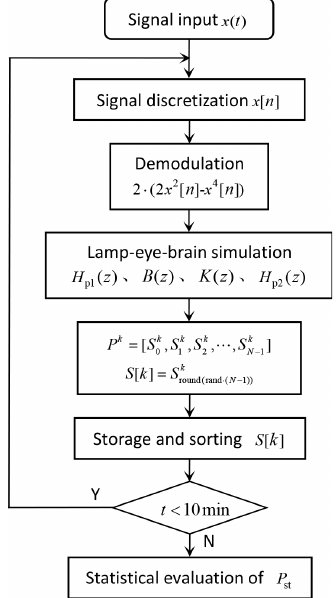
Figure 3. Flowchart of probability resampling flicker detection.